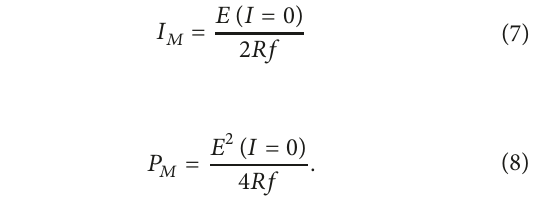
potential difference that corresponds to E ( I = 0 ) is the potential difference at